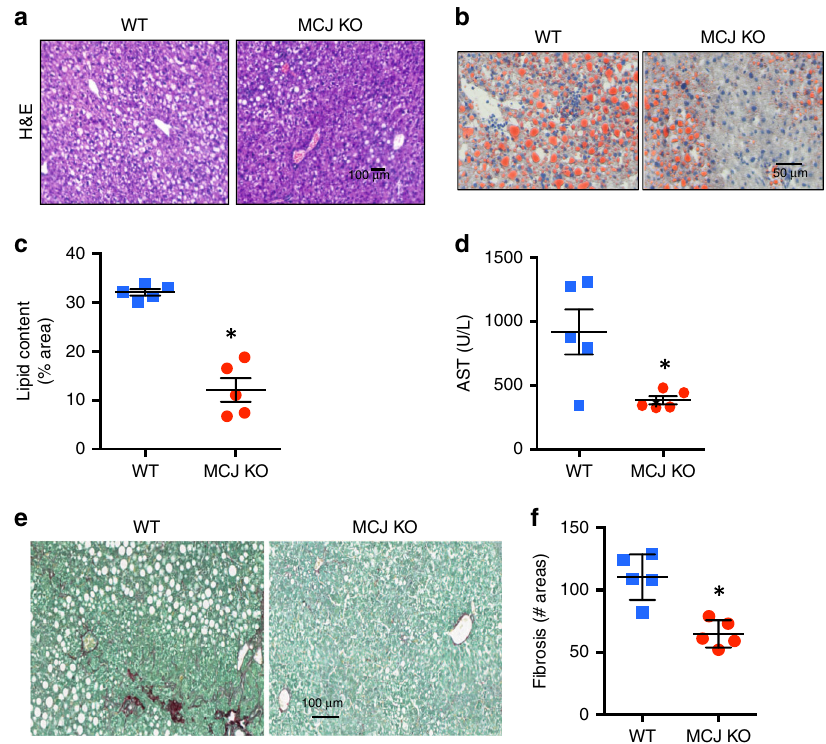
Fig. 1 MCJ de fi cient mice are resistant to develop liver steatosis and fi brosis in the MCD diet model. ( a – d ) WT ( n = 5) and MCJ KO ( n = 5) mice were placed on MCD (methionine- and choline-de fi cient) diet for 2 weeks prior to liver harvest. a Representative liver H&E images from WT and MCJ KO mice. b Representative images and ( c ) quantitation of liver lipid content determined by Sudan III staining and shown as percentage of the total histological area. ( d ) Serum AST levels. e, f WT ( n = 5) and MCJ KO ( n = 5) mice were placed on MCD diet for 3 weeks prior to liver harvest. e Representative images and ( f ) quanti fi cation of liver fi brosis determined by Picro Sirius Red staining and shown as the number of fi brotic areas per histological section. *denotes p < 0.05 as determined by Student´s t test. Error bars show standard error (SE) in ( c ) and ( d ), and standard deviation (SD) in ( f ). Source data are provided as a Source Data fi